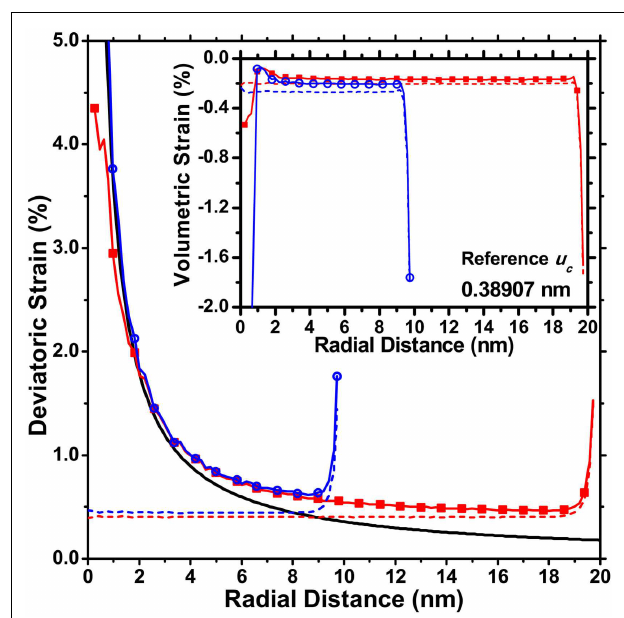
FIGURE 11 | Plot of the r.m.s. strain as a function of the Fourier length, L , taken along the scattering vector direction inside the cylindrical domains: D = 20nm/ H = 28.7nm (A) and